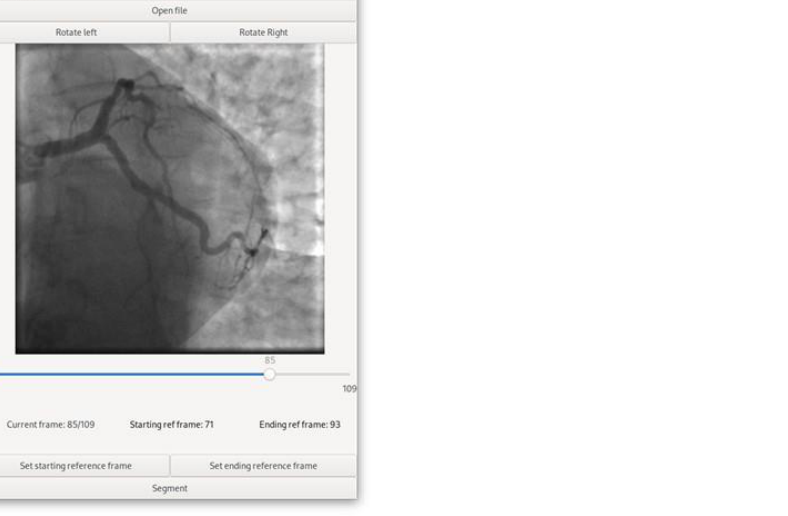
Figure 2. Graphical appearance of the CoroFinder software. In particular, the main page is depicted in the figure.